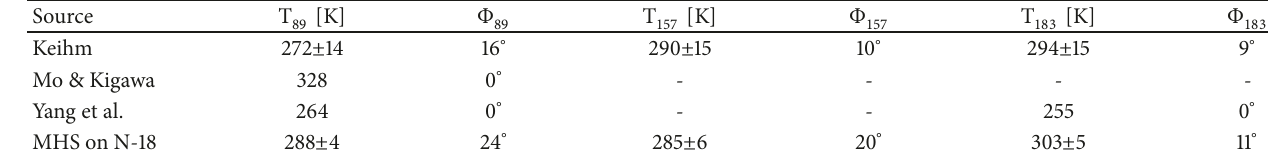
Table 2: Maximum brightness temperature of the Moon at different frequencies and the phase of its occurrence. Source T 89 [ K ] Φ 89 T 157 [ K ] Φ 157 T 183 [ K ] Φ 183 Keihm 272 ± 14 16 ∘ 290 ± 15 10 ∘ 294 ± 15 9 ∘ Mo & Kigawa 328 0 ∘ - - - - Yang et al. 264 0 ∘ - - 255 0 ∘ MHS on N-18 288 ± 4 24 ∘ 285 ± 6 20 ∘ 303 ± 5 11